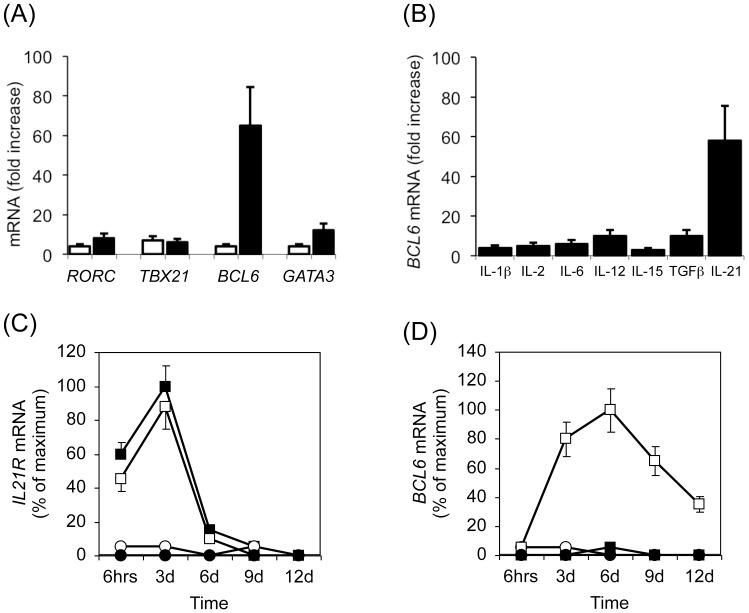
Antigen and IL-21 differently regulate expression of lineage-specifying transcription factors in Vγ9Vδ2 T cells.Vγ9Vδ2 T cells were cultured with an equal number of irradiated DCs and IPP, in the presence of IL-21. (A) RT-PCR of the expression of RORC, TBX21, GATA3 and BCL6 in cells primed with antigen in the absence (white columns) or presence (black columns) of IL-21. (B) RT-PCR of the expression of BCL6 on Vγ9Vδ2 T cells that had been cultured with antigen in the presence of different cytokines. (C) and (D), RT-PCR of the expression of IL21R (C) and BCL6 (D), in Vγ9Vδ2 T cells primed for various times (horizontal axes) with medium (filled circles), with IL-21 alone (open circles) or with antigen but in the absence (filled squares) or presence (open squares) of IL-21. Data represent the mean values ± SD of five separate experiments, each carried out with cells from three different donors.